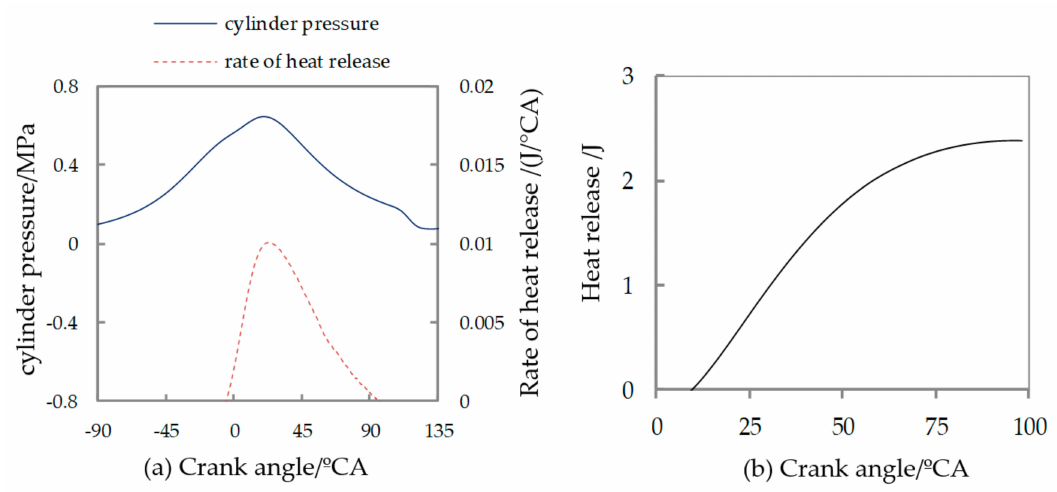
Figure 2. ( a ) Cylinder pressure and ( b ) heat release for methanol fuel.